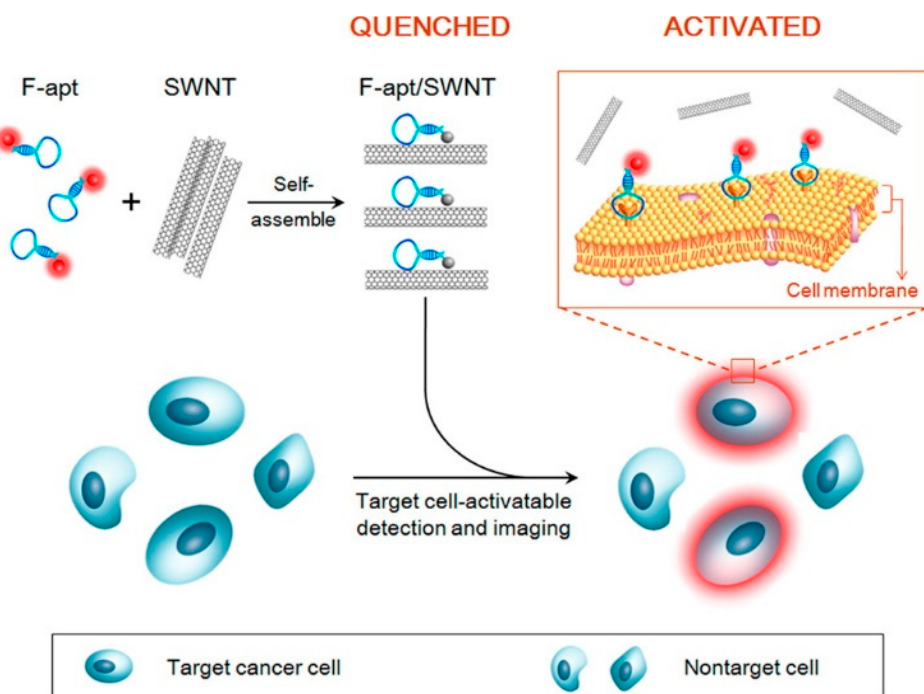
Figure 21. Schematic representation of the activatable fluorescence probing strategy for target CCRF-CEM cancer cells based on the self-assembly between a fluorophore-labelled aptamer (Cy5-labeled sgc8c) and single-walled carbon nanotubes (SWNT). Figure reproduced with permission from reference. [232]. Copyright © 2014 American Chemical Society.